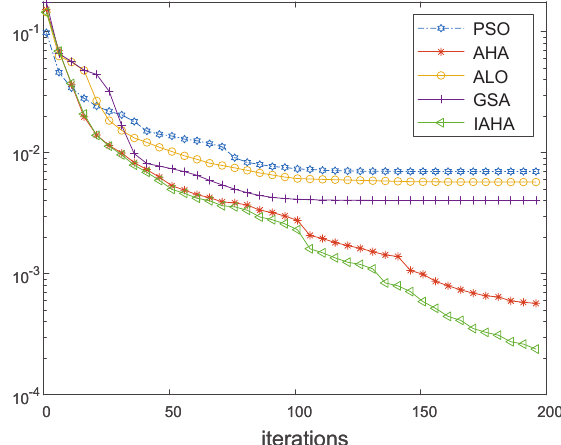
Figure 11. Comparison of the average iteration process under a 10% frequency disturbance condition.